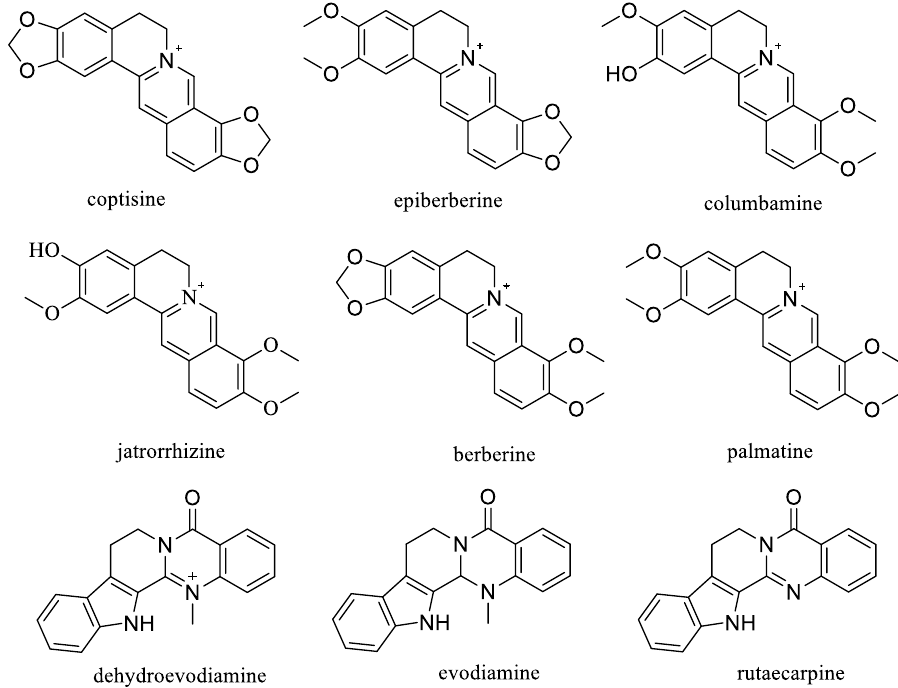
Figure 8. Chemical structures of nine markers for quantification.